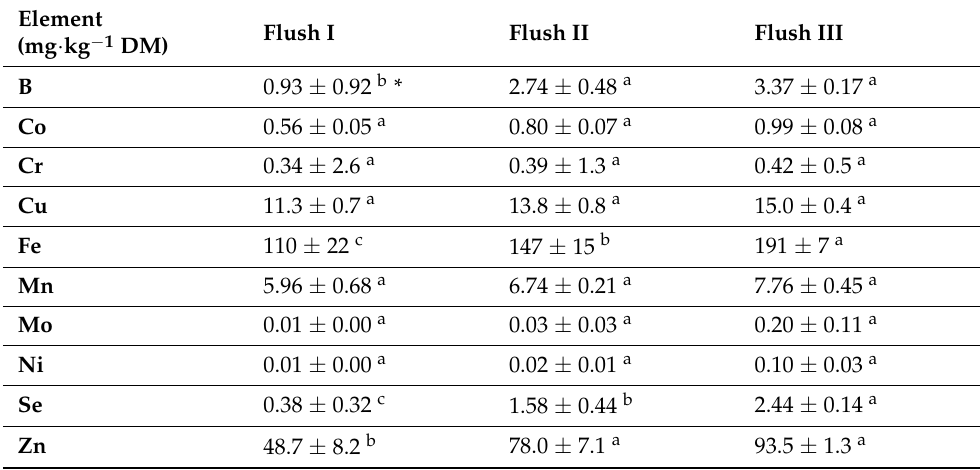
Table 4. Concentrations of ETEs in the fruiting bodies of P. djamor cultivated on EMS.